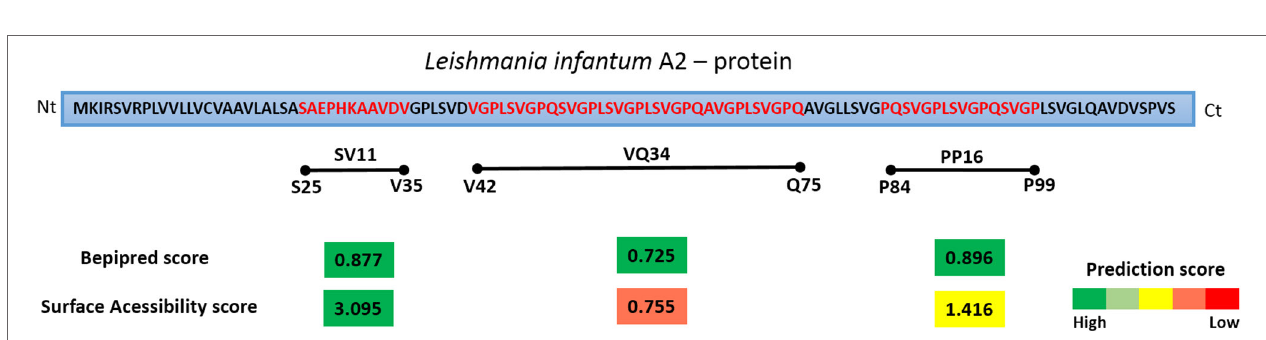
FigUre 2 | Schematic diagram of L. infantum A2 protein and the predictions scores for linear B cell epitopes and Surface Accessibility. The regions corresponding to the residues 25–35, 42–75, and 84–99 of L. infantum A2 protein were selected for the synthesis of a soluble peptide based on the best prediction scores determined for both features. The prediction scores represents the average of scores for all amino acids within the region with prediction values above the cut-offs chosen for significance. The bar colors represent the intensity of prediction scores found, from green (high score) to red (low score).